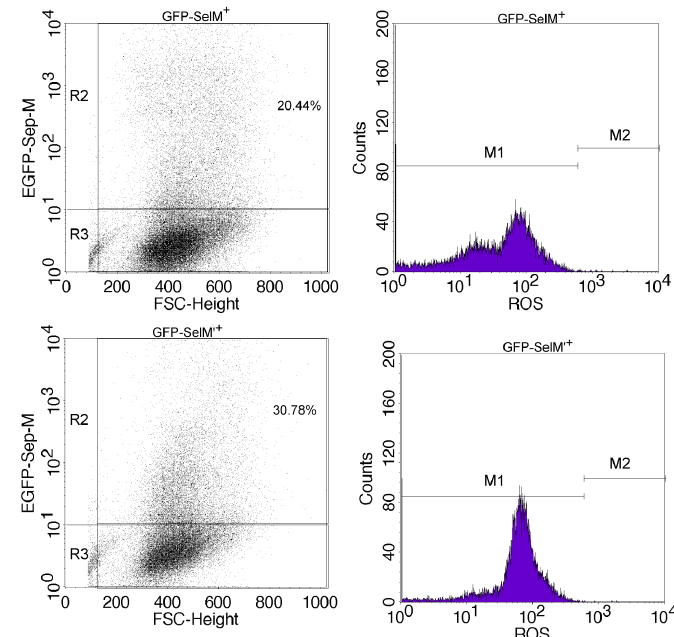
Figure 3. Effect of different forms of SelM on intracellular reactive oxygen species (ROS) generation. HEK293T cells were transfected with different plasmids with or without the addition of 0.5 μ mol/L Na SeO , followed by the treatment with 10 µM Na SeO for 6 h to 2 3 2 3 generate oxidative stress. The transfection efficiency (left panel in each group) and the ROS level (right panel in each group) were measured by flow cytometry. The percentage of transfected cells (R2) vs. untransfected cells (R3) is shown in the left panel. GFP-SelM + , GFP-SelM' + , GFP-SelM, and GFP + represent those cells transfected, respectively the plasmids of pSelExpress1- GFP-SelM , pSelExpress1- GFP-SelM  , pSelExpress1- GFP-SelM , and pSelExpress1- GFP . All cells, except those in the GFP-SelM SeO for 24 h. This is the one representative group, were cultured under 0.5 μ mol/L Na 2 3 profile of three